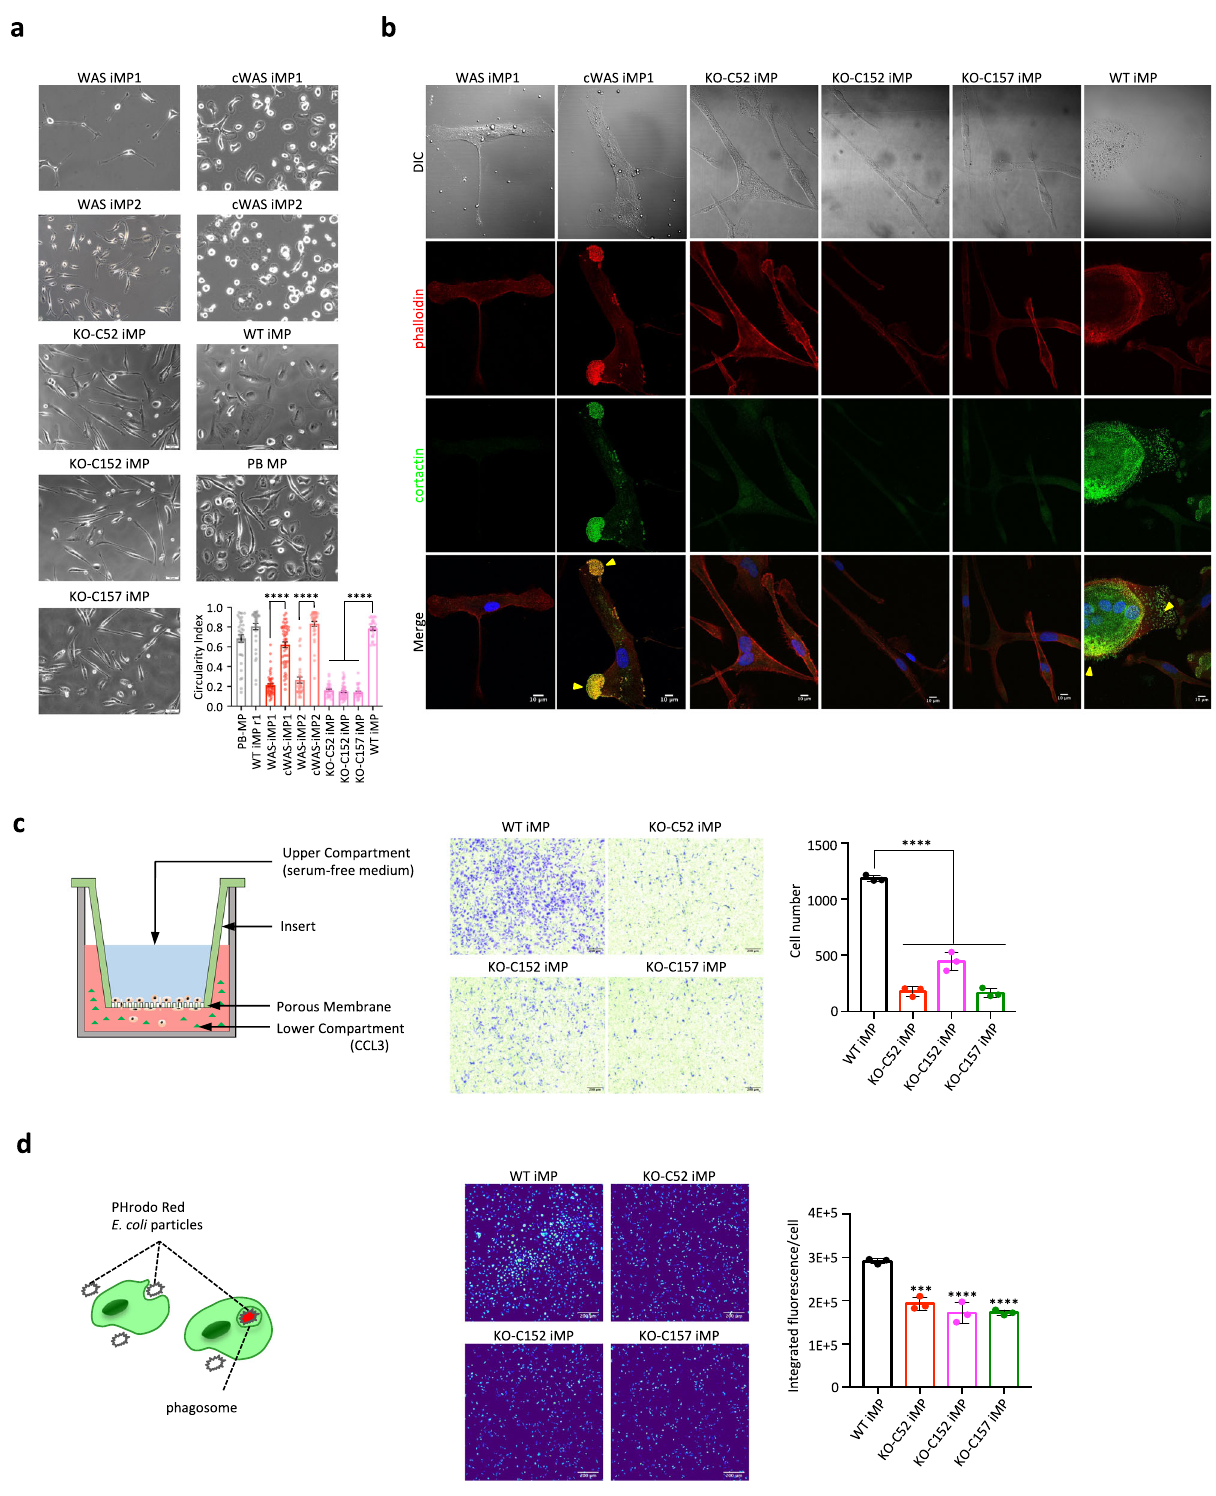
protein expression using the data-independent acquisition mass spectrometry (DIA-MS). As expected, the DIA-MS data showed that WASP was the most signi fi cantly downregulated protein in KO-iMPs (Fig. 3g). Consistent with the RNA-seq data, 124 RNA SFs were overexpressed at the protein level in KO-iMPs (Supplementary Data 1), of which 46 overlapped with those detected by RNA-seq in either patient iMPs or KO-iMPs (Fig. 3h). In contrast, only 8 SFs were downregulated in the DIA-MS data.